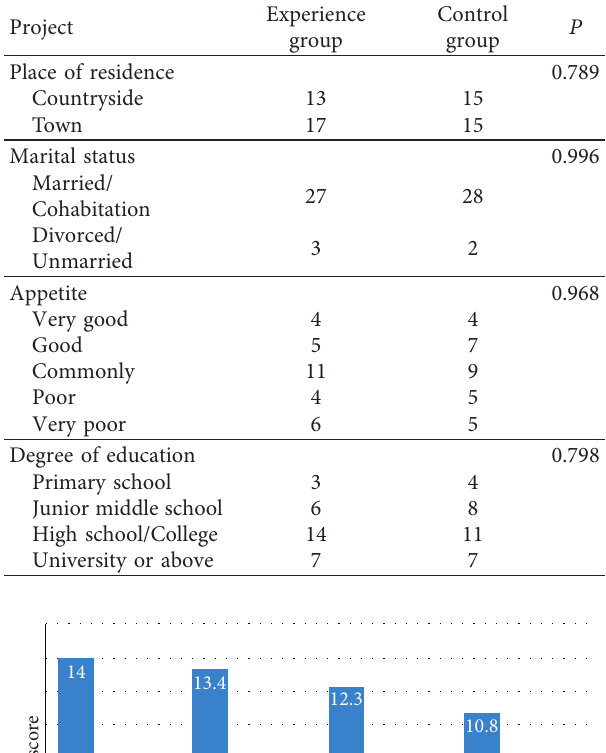
Table 1: Questionnaire of general information of patients.